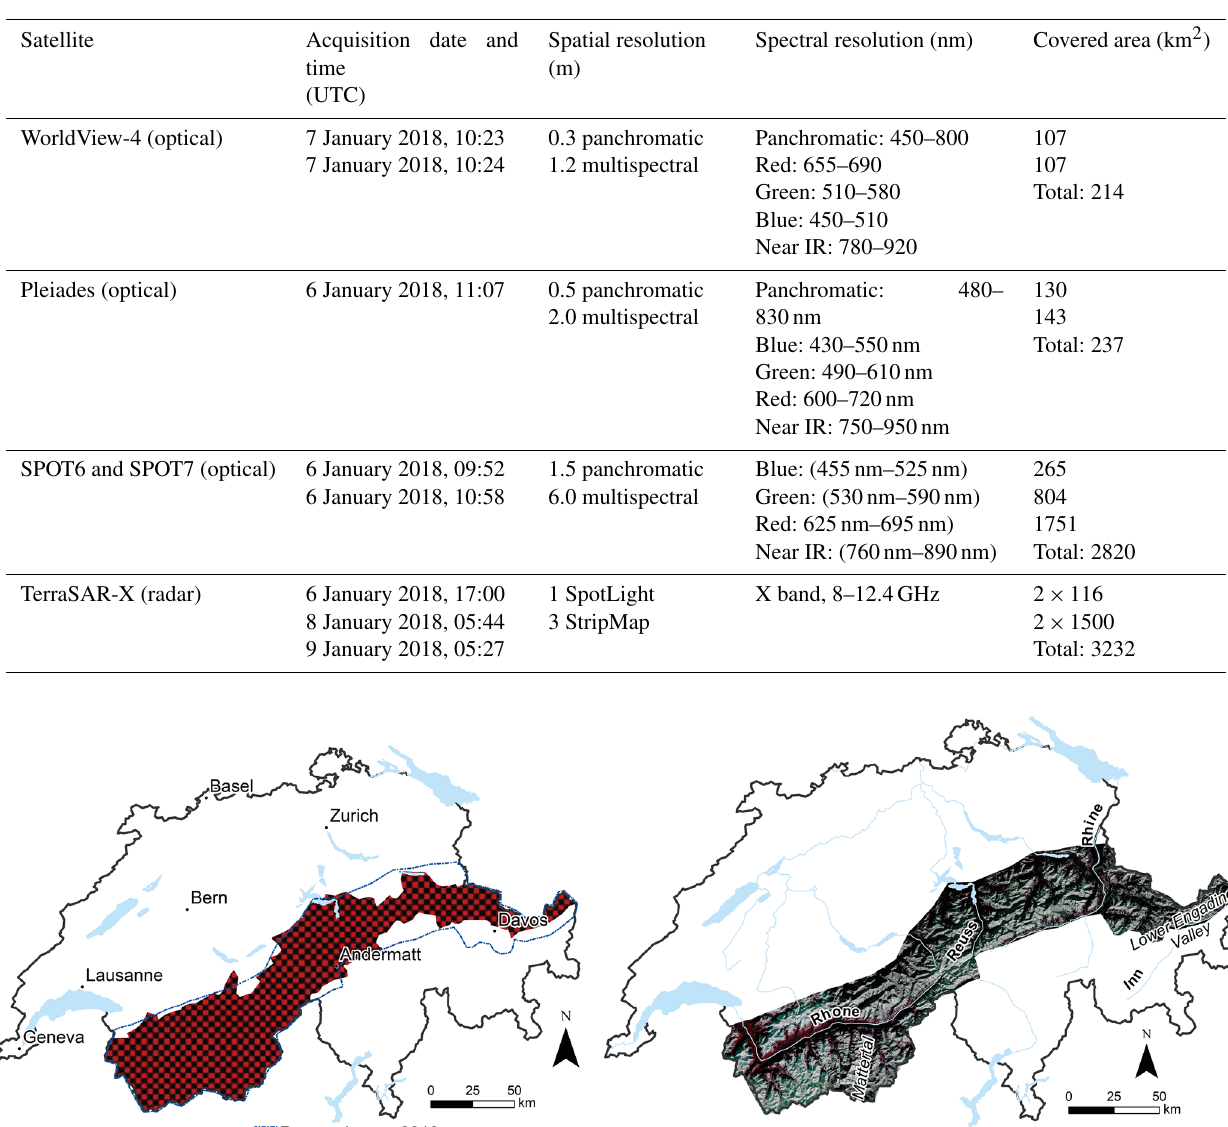
Table 1. Acquired satellite datasets for the first period.